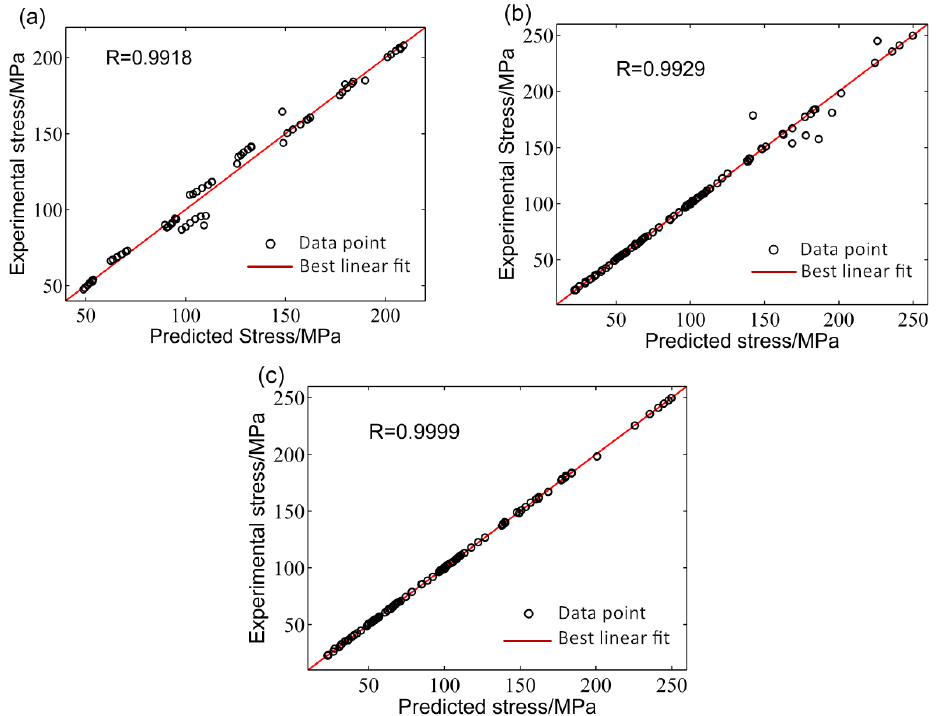
Figure 13. The AARE of the ( a ) BP–ANN and ANN–GA models at true strains of 0.01 – 0.06; and ( b ) Arrhenius, BP–ANN, and ANN–GA models at true strains of 0.1 – 0.7. After the above statistical analysis, the flow behavior of 5754 aluminum alloy could be accurately and reliably predicted by the developed ANN–GA model. In addition, the SA model contains a large number of model constants that need to be calculated repeatedly. The time it took to build the ANN model was shorter than the time required to build the phenomenological model. 3.6. The Dynamic Softening Mechanism of 5754 Aluminum Alloy As shown in Figure 11, the 5754 aluminum alloy showed the typical rheological characteristics during the hot compression tests. The flow stress rose rapidly with an increase in the strain until it reached the peak. After this, the flow stress did not significantly change with increasing strain, which demonstrated a steady flow softening phenomenon. Moreover, the flow stress increased with a decrease in the deformation temperature and an increase in strain rate. It can be seen that the 5754 aluminum alloy possessed the property of strain rate dependence. In addition, the required strain for reaching the steady state deformation increased with increasing strain rate and decreasing temperature. The cross-slip of the screw dislocation and the climbing of the edge dislocation were difficult to carry out fully. Furthermore, the softening degree provided by the cross-slip and climbing was small under the conditions of a lower deformation temperature and higher strain rate, which can cause steady-state stress hysteresis. The aluminum alloy had a high stacking fault energy (SFE). Perfect dislocations were difficult to transform into partial dislocations and stacking faults, while the dynamic recovery (DRV) process required a large amount of stored energy during the process of hot deformation. Therefore, the driving force required for the dynamic recrystallization (DRX) of the alloy decreased, which increased the difficulty of DRX. The deformation microstructure of the 5754 aluminum alloy deformed at a strain rate of 0.1 s −1 and temperature of 500 C is shown in Figure 14. It can be seen